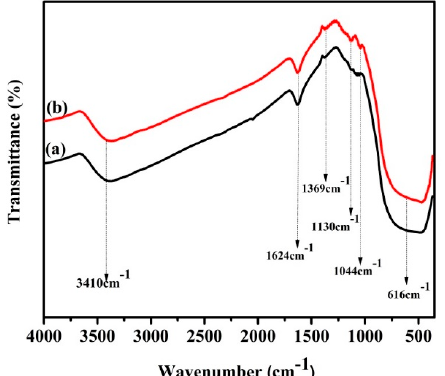
Figure 3. Fourier transform infrared spectra of NaYF 4 :Yb,Er coated with ( a ) N-TiO 2 and ( b ) CNS-TiO 2 . Figure 4 exhibits UV-Vis absorption spectra of NaYF 4 :Yb,Er coated with undoped, N-doped, and CNS-doped TiO 2 . The NaYF 4 :Yb,Er phosphor absorbs UV light from 200 nm with an edge at 250 nm (due to the NaYF 4 host), and in Figure S9 absorption peaks were centered at 524 and 654 nm due to